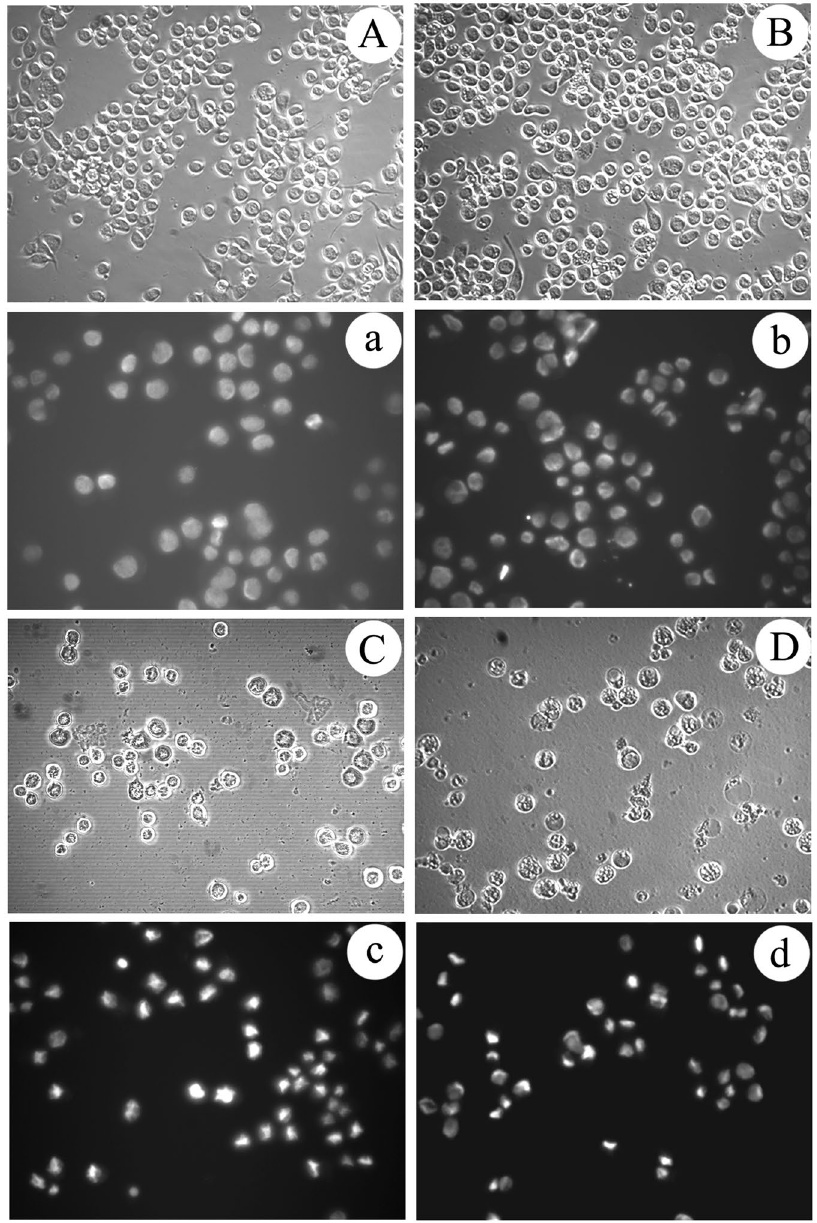
contrast microscopy), with small letters from FM (fluorescence microscopy); magnification was 200X . ( A ) Morphological characteristics of cell in control; (a) Morphological characteristics of cell nucleus in control; ( B ) Morphological changes of cell induced by matrine; (b) Nucleus morphological changes of cell induced by matrine; ( C ) Morphological changes of cell induced by matrine derivative 1; (c) Nucleus morphological changes of cell induced by matrine derivative 1; ( D ) Morphological changes of cell induced by matrine derivative 2; (d) Nucleus morphological changes of cell induced by matrine derivative